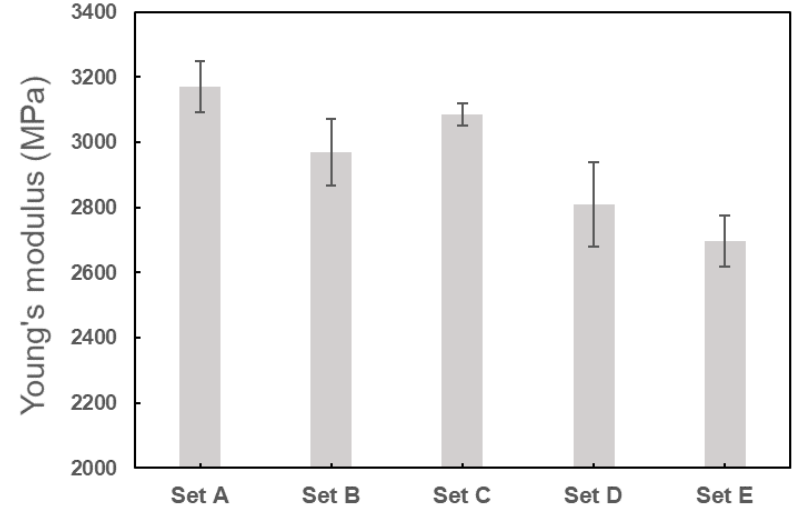
Figure 9. Experimental data of Young’s modulus for each set of specimens.